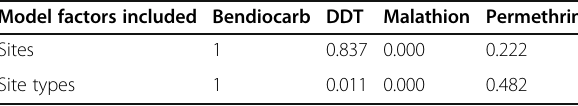
Table 3 GLM testing the effects of site and site type on bioassay mortality for each